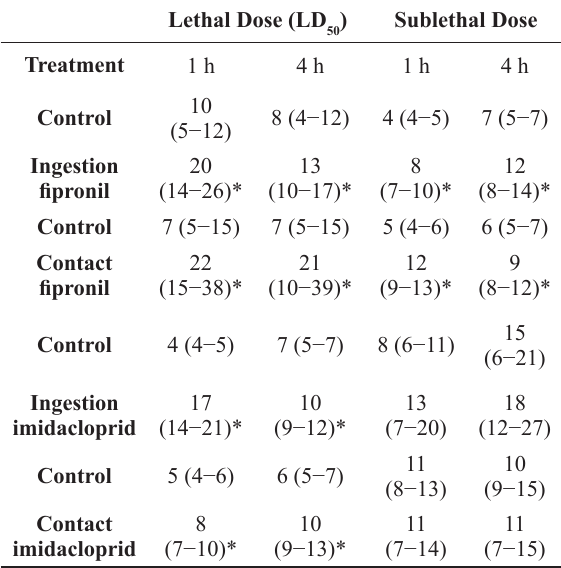
Time (seconds) spent by African-derived Apis mellifera walking along a 50-cm track after exposure to the lethal dose (LD ) or sublethal dose (1/500 th of the LD 50 fipronil or imidacloprid, by ingestion or contact, at 1 and